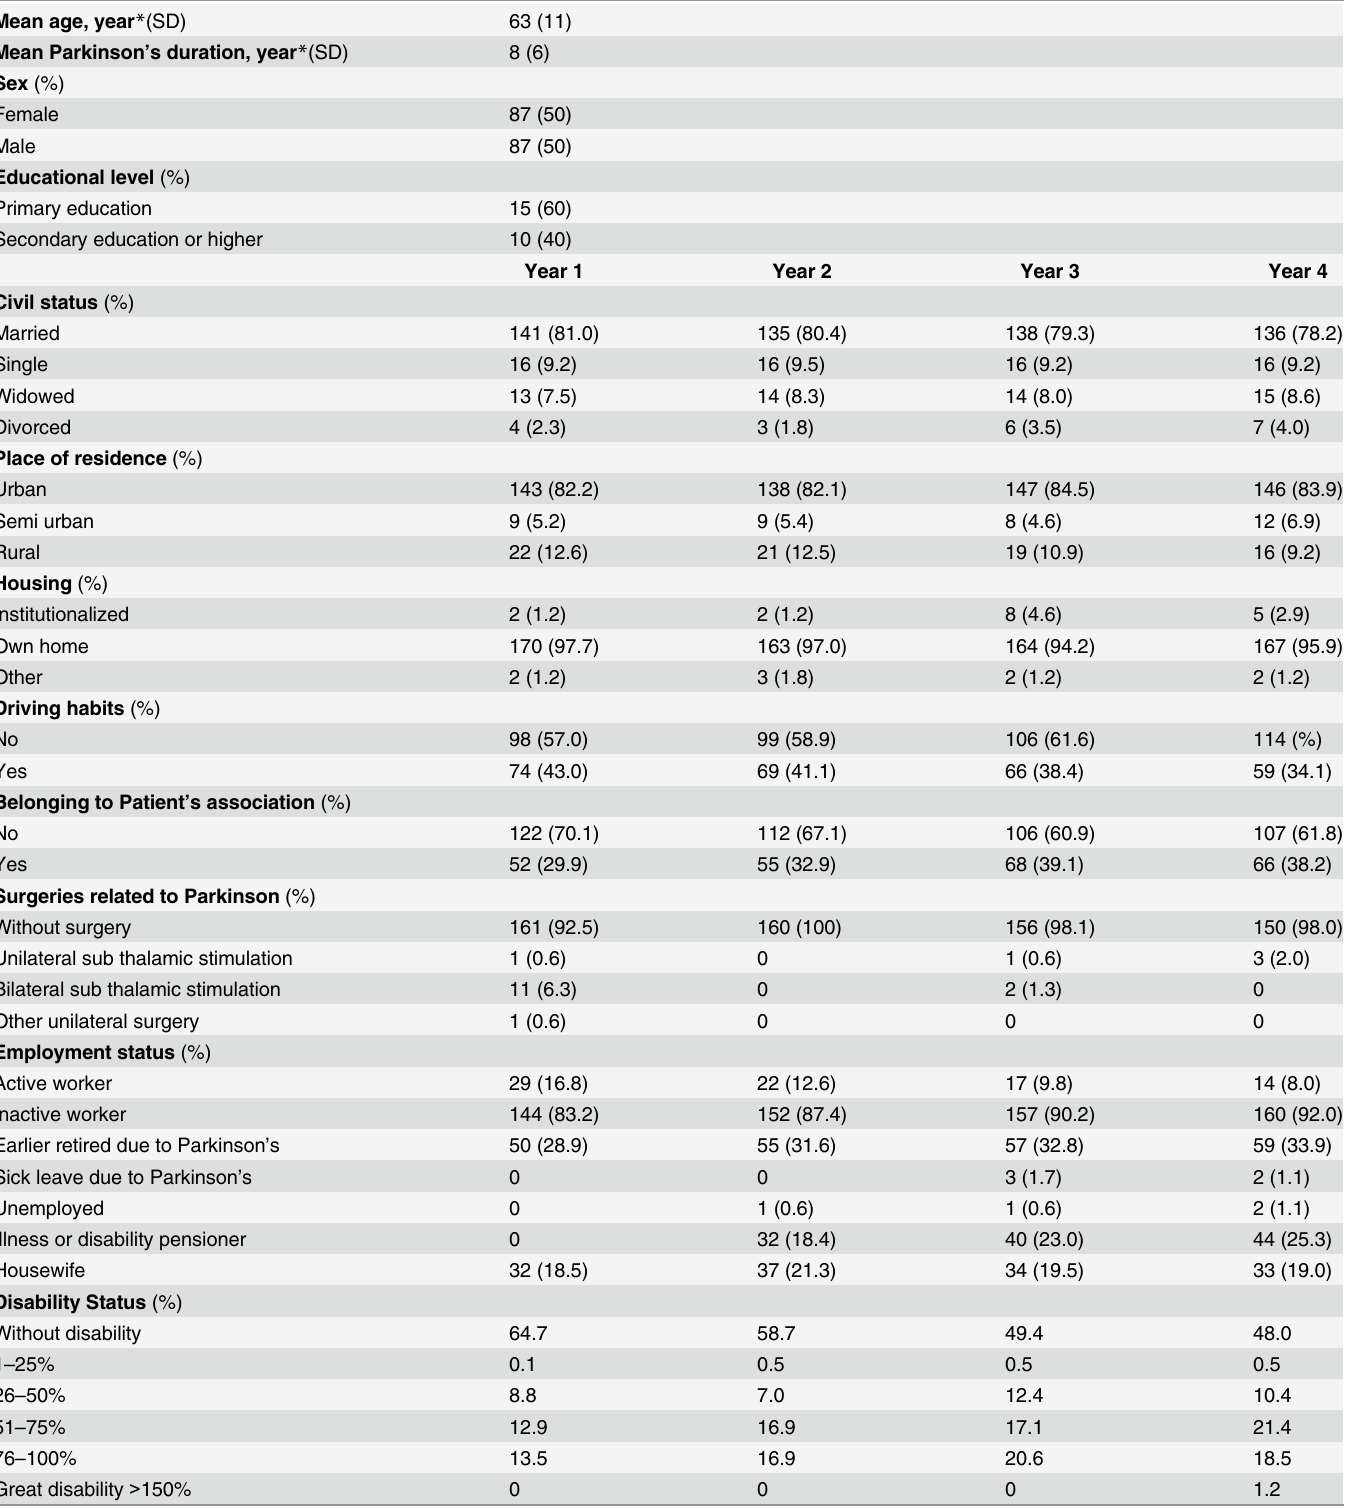
Table 1. Patient ’ s